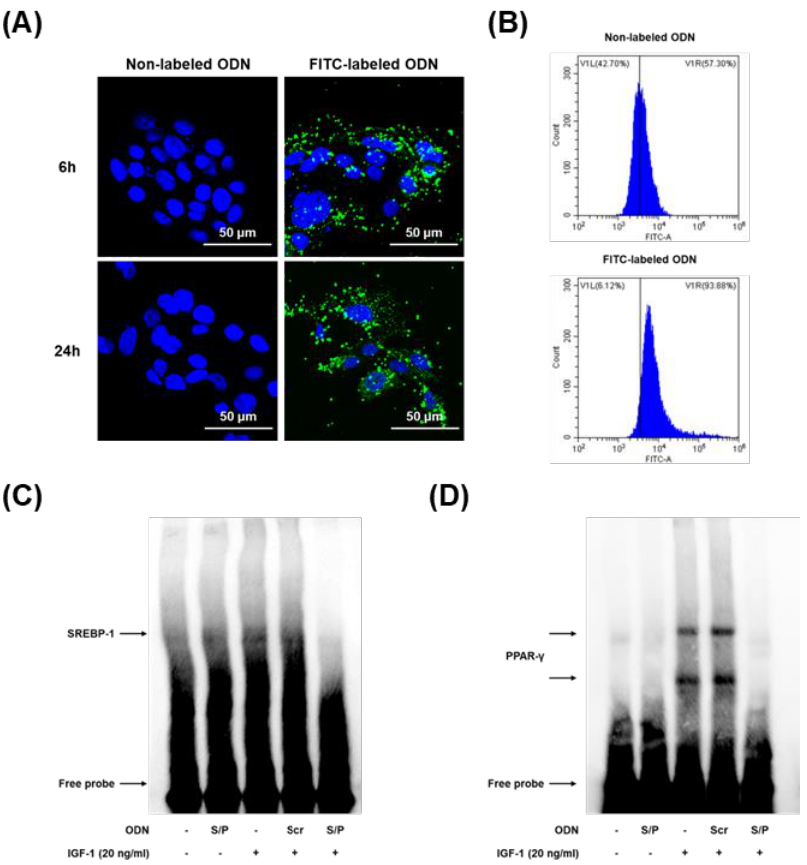
Figure 5. Confirmation of the FITC-labeled SREBP/PPAR chimeric decoy ODN in SZ95 cells. ( A ) Representative immunofluorescence images showing the fluorescence activity in both the cytoplasm and nucleus detected via FITC-labeled ODN deposition (green). DAPI (blue)-stained nuclei. ( B ) The transfection efficiency of the FITC-labeled decoy ODN was measured using flow cytometry. The effect of the SREBP/PPAR chimeric decoy ODN on ( C ) SREBP-1 and ( D ) PPAR- γ transcription activity. EMSA was performed to analyze the effect of the SREBP/PPAR chimeric decoy